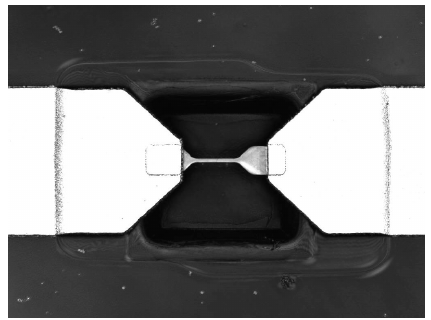
Figure 2. Titanium micro-bridge with cavity.